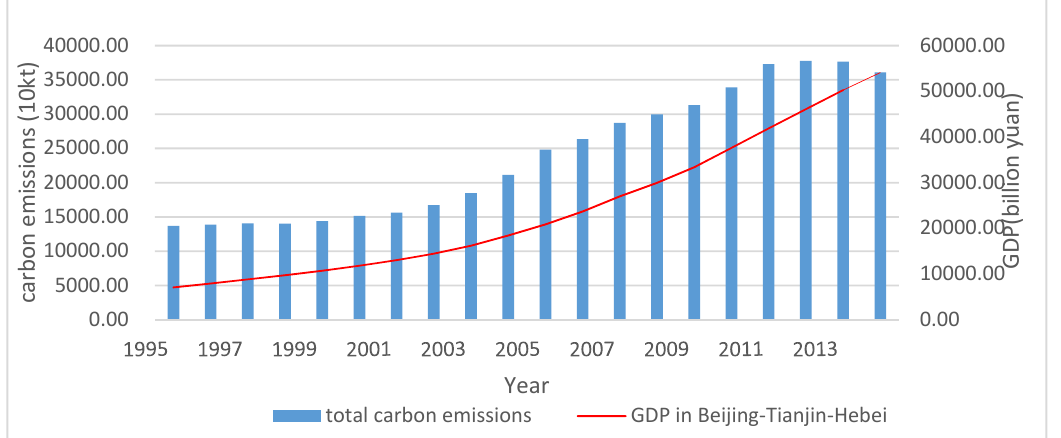
Figure 2. The relationship between the total carbon emissions and GDP in the Beijing-Tianjin-Hebei region from 1995 to 2014. Figure source: The GDP of Beijing, Tianjin, Hebei provinces were derived from the Beijing Statistical Yearbook, Tianjin Statistical Yearbook, and Hebei Economic Yearbook. Moreover, the GDP was be converted to 1995 price to eliminate inflation.